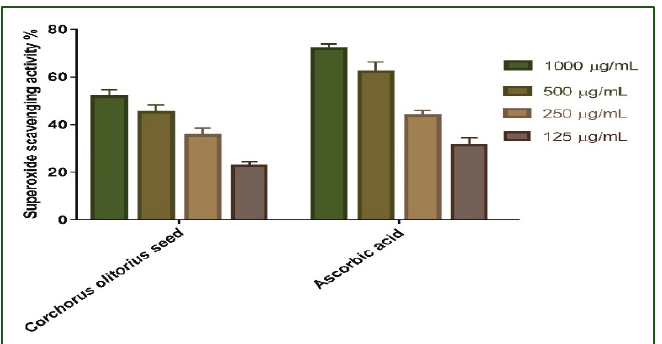
Figure 2. Superoxide radical scavenging activity of Corchorus olitorius seed extract at different concentrations (1000, 500, 250, and 125 µ g/mL). Bars represent mean ± SD (standard deviation). Significant difference between groups is analyzed by a Two-way ANOVA test after normalization of variables by the Shapiro Wilk test.